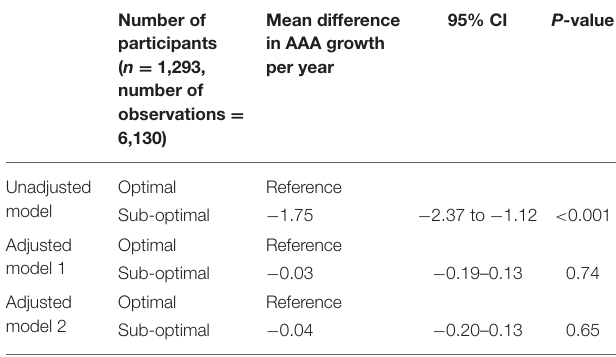
TABLE 2 | Association between optimal blood pressure control and AAA